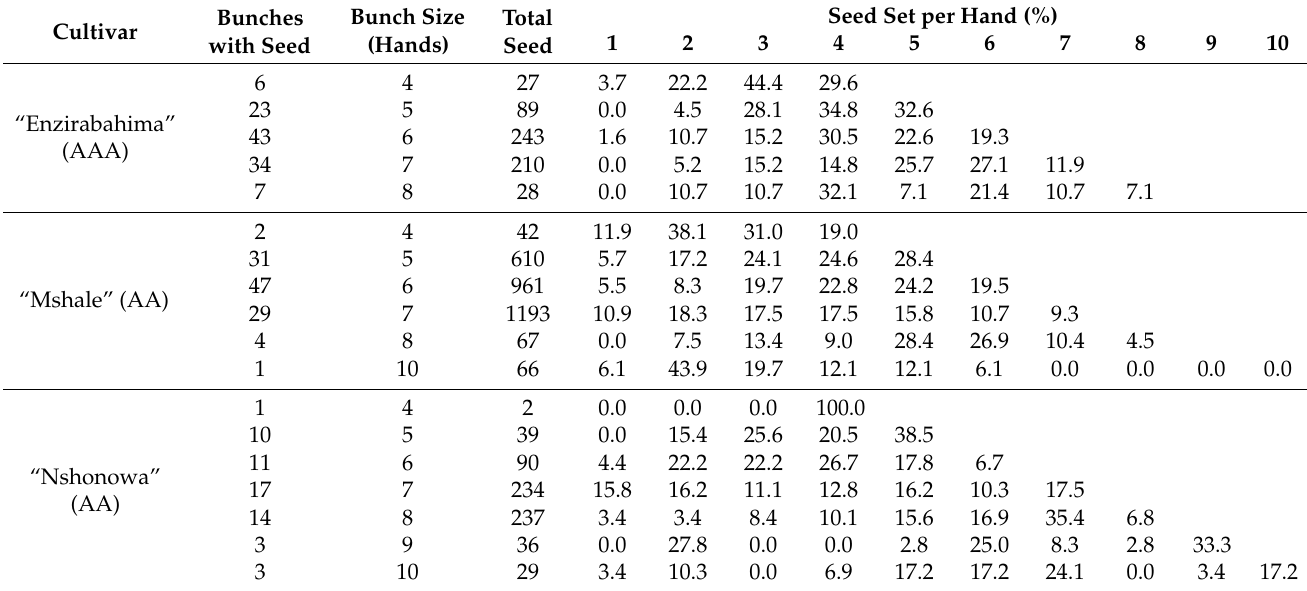
Table 1. Percentage seed set per hand and by number of hands per bunch in “Enzirabahima”, “Mshale”, and “Nshonowa”.